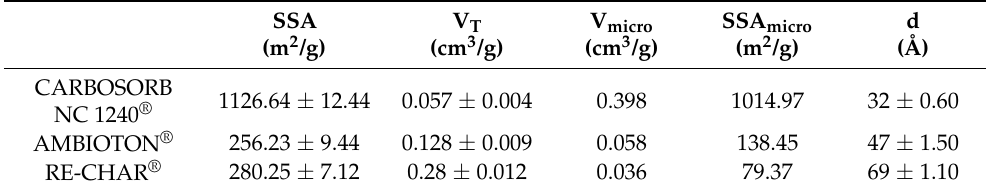
Table 2. BET and BJH data of carbonaceous